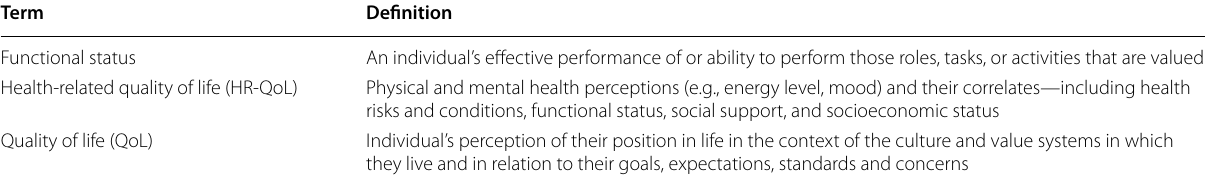
Table 1 Definitions of selected terms related to quality of life Term Definition Functional status An individual’s effective performance of or ability to perform those roles, tasks, or activities that are valued Health‑related quality of life (HR‑QoL) Physical and mental health perceptions (e.g., energy level, mood) and their correlates—including health risks and conditions, functional status, social support, and socioeconomic status Quality of life (QoL) Adapted from Higgins PT, Green S. Cochrane Handbook for Systematic Reviews of Interventions (Version 5.1.0); Centers for Disease Control and Prevention. Measuring Healthy Days: Population Assessment of Health-related Quality of Life (2000); and The WHOQOL Group. The World Health Organization Quality of Life Assessment (WHOQOL). Development and Psychometric Properties. Soc Sci Med . 1998;46:1569–1585